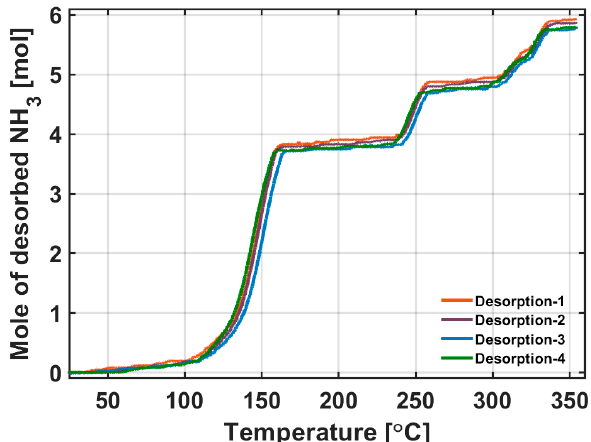
Figure 8. A series of NH 3 desorption from Mg 0.5 Mn 0.5 (NH 3 ) 6 Cl 2 . The four cycles confirm the stability and cyclability of the mixed metal halide after several ab/desorption cycles.